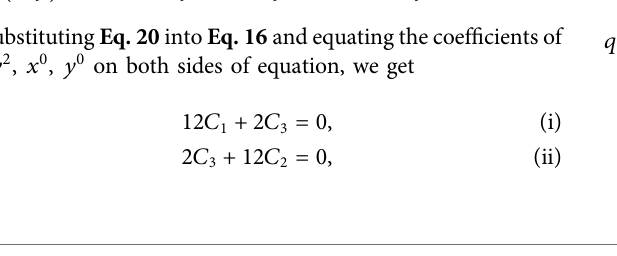
Frontiers in Physics |